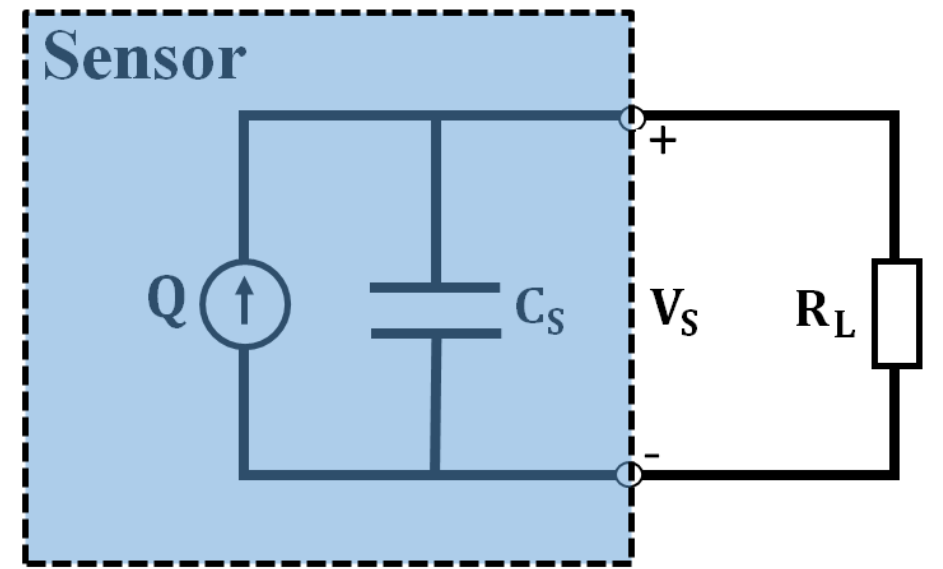
Figure 5. Equivalent circuit model for a piezoelectric sensor.